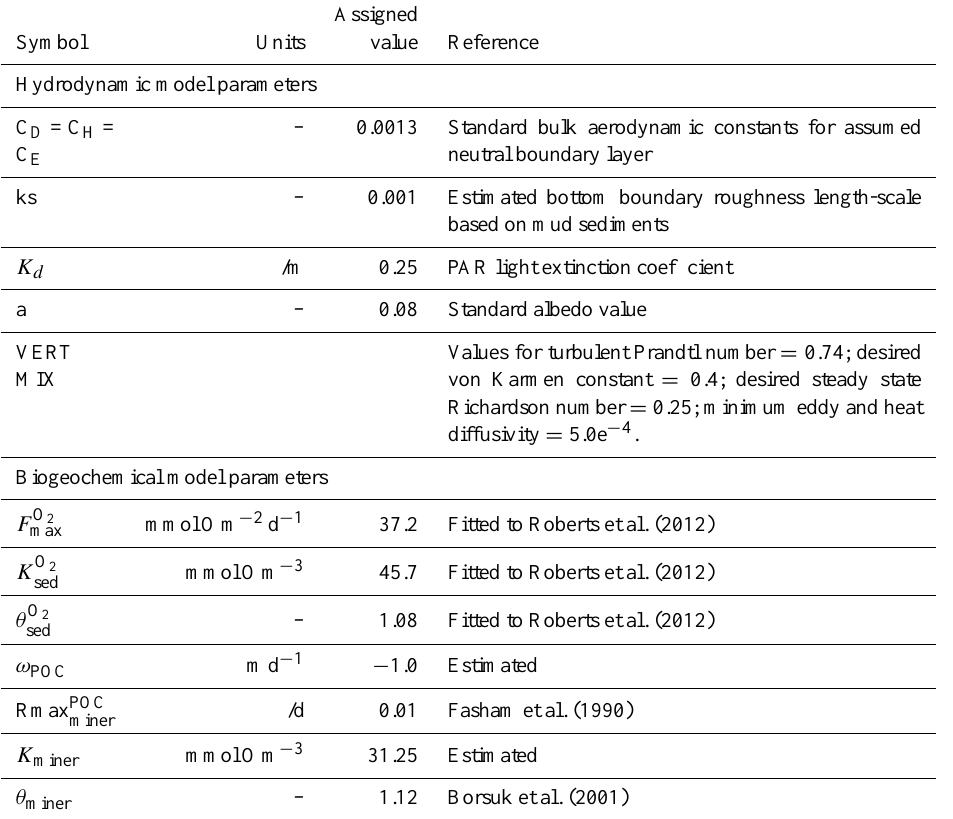
Table 2. Parameters used in the coupled model simulations.